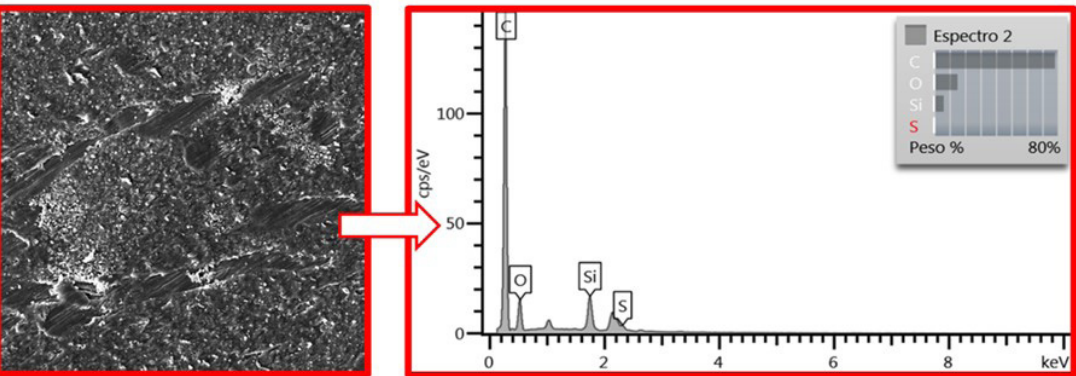
Figure 6. Composition of char layer of ablated